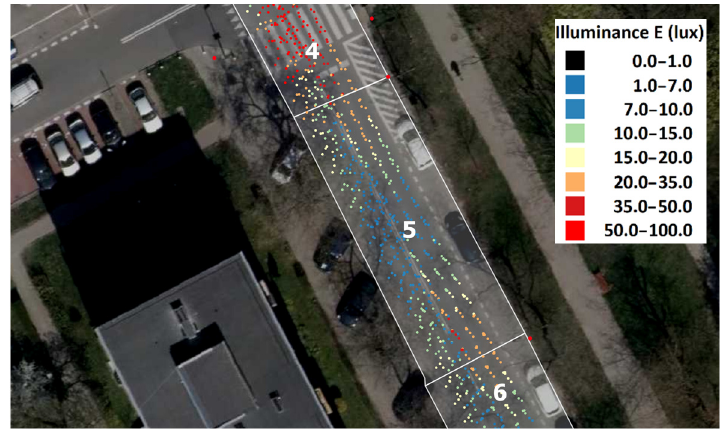
Figure A3. Example of five illuminance measurements in field No. 5.